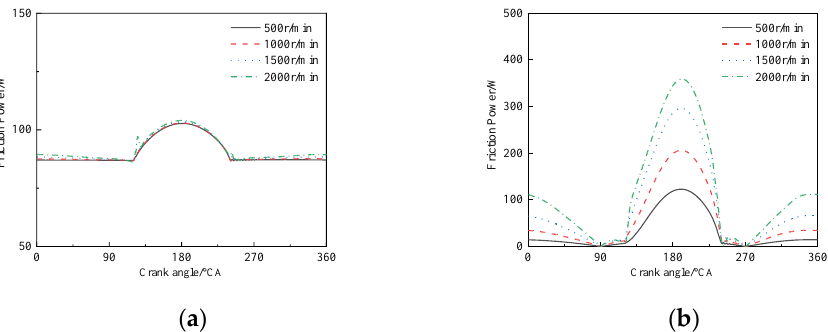
Figure 20. ( a ) Hydrodynamic lubrication friction power under different engine speeds. ( b ) Asperity contact friction power under different engine speeds.